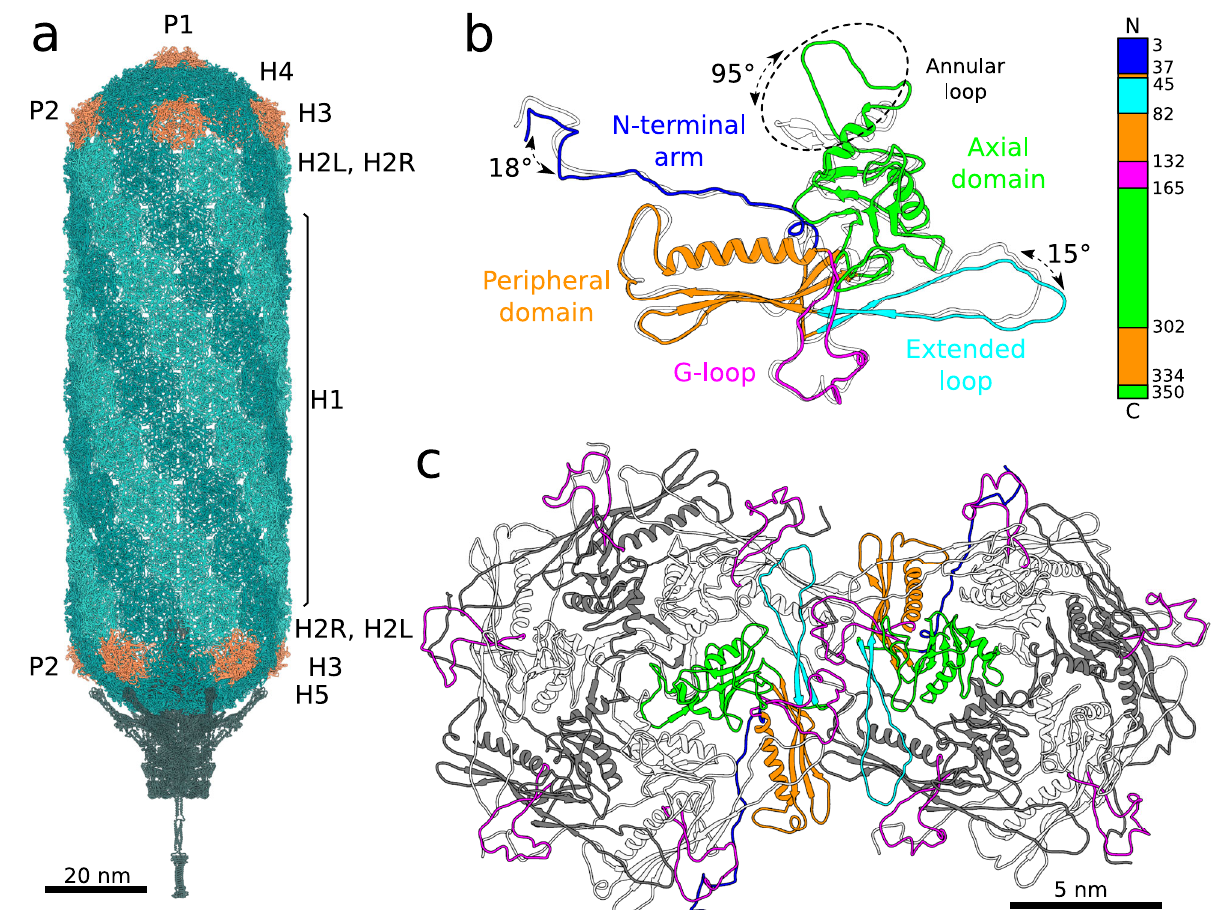
Fig. 3 | SU10 capsid and major capsid protein. a Cartoon representation of pro- teins forming virion of phage SU10. The prolate capsid has fi vefold symmetry and the capsid proteins are organized with the parameters of T end =4, T mid =20. Pen- tamers of capsid proteins are shown in orange, hexamers in dark cyan or light sea green. Pentamers are of two types, based on their position in the capsid. The P1 pentamer is positioned on the fi vefold axis of the particle, whereas the remaining P2 pentamers are positioned on quasi- fi vefold axes at the borders between the tubularpart of the capsid and the caps. Thereare six variants of hexamers: H1 that formthecentralpartoftheprolatehead;H2LandH2Rbelongtothecentralpartof the capsid but interact with terminal caps; H3 are between P2 pentamers; H4 are between P1 and P2 pentamers; and H5 are between P2 pentamers and the portal